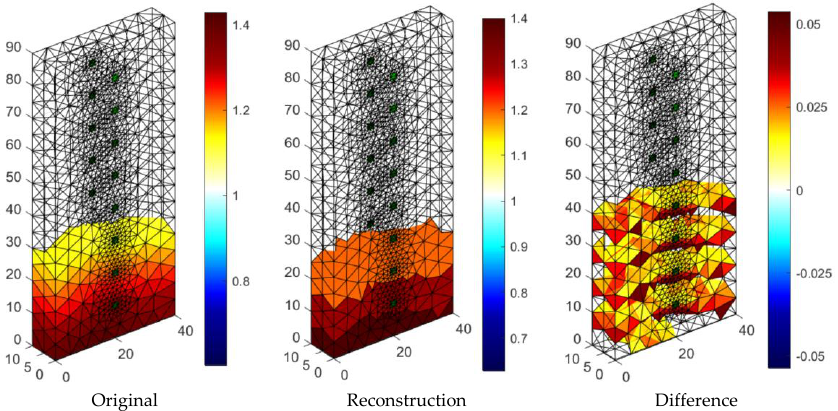
Figure 19. The result of Artificial Neural Network system (ANN) moisture testing of the lightweight concrete block for the case of 2 × 8 electrodes.